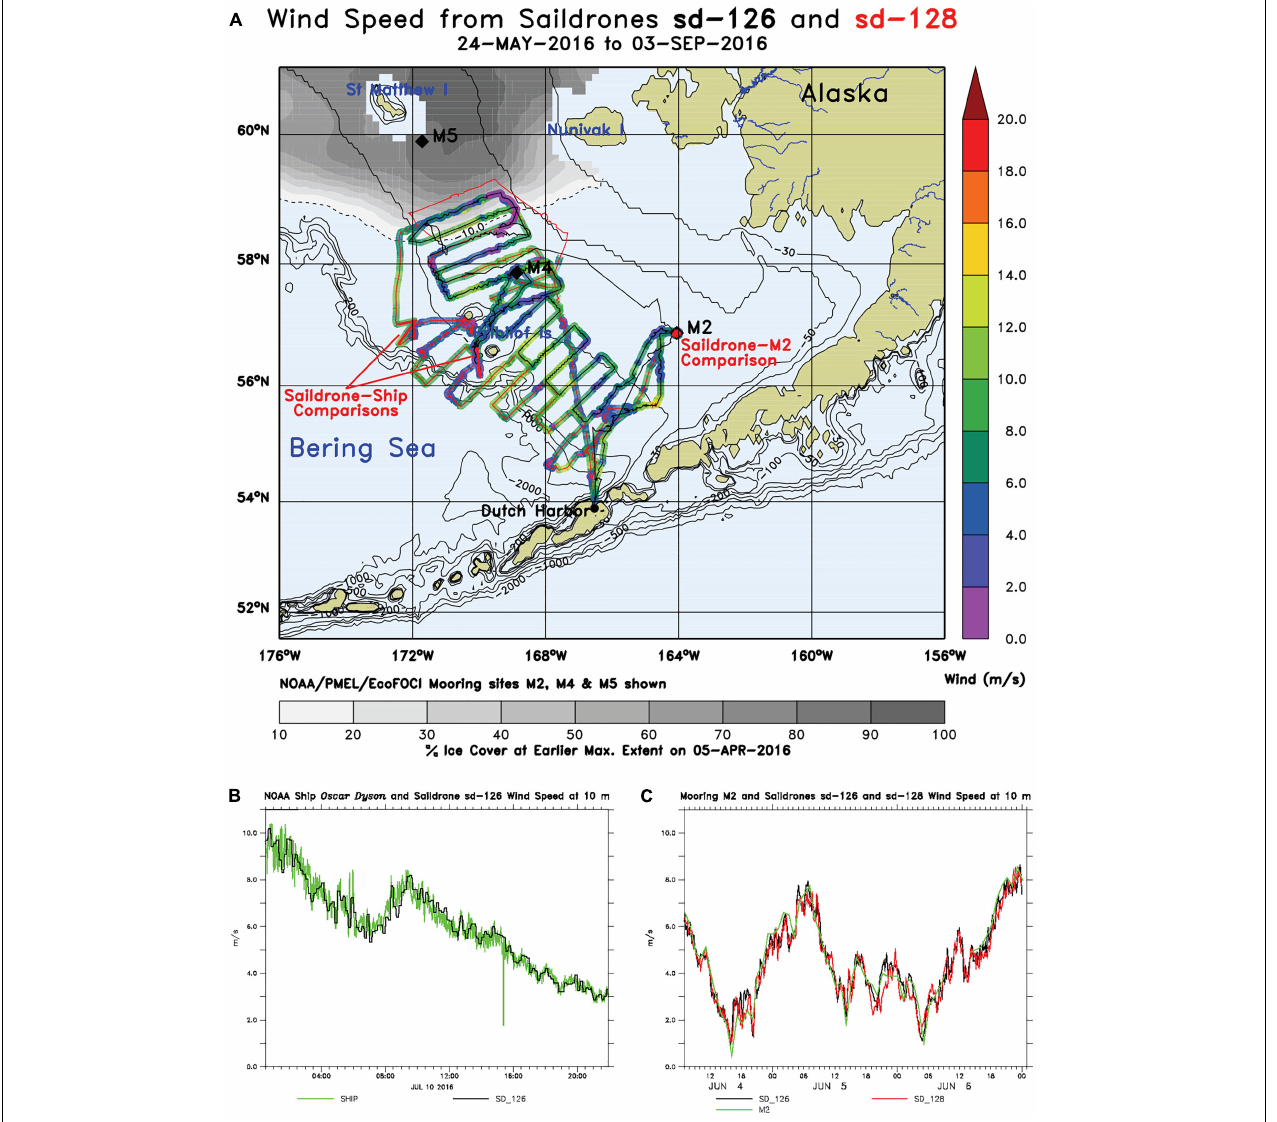
FIGURE 5 | (A) Map of the wind speed (m/s) along the tracks of two Saildrone USVs in the Bering Sea, 24 May–3 September 2016. Saildrone USV sd-126’s track line is black, and sd-128’s is red. During this 103-day mission, the mean wind speed was 5.7 m/s with peak gusts to 23 m/s. Also shown are the sites of the comparisons between the Saildrone USVs and NOAA Ship Oscar Dyson and NOAA/PMEL research mooring M2. (B) The wind speed as measured by the ship (green) and Saildrone USV sd-126 (black). The comparison is good with an rms difference of 0.44 m/s. (C) The wind speed as measured by mooring M2 (green) and Saildrone USVs sd-126 (black) and sd-128 (red). The rms differences between the M2 and Saildrone USV winds were 0.49 and 0.54 m/s,